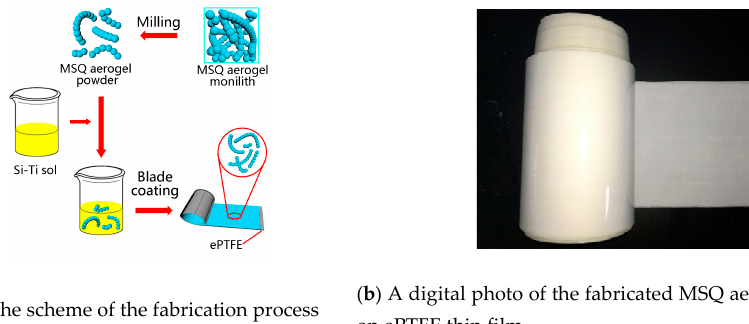
Figure 2. ( a ) The fabrication process for an MSQ aerogel coating layer on Polytetrafluoroethylene (ePTFE) thin film; ( b ) a digital photo of the fabricated large-scale MSQ aerogel coating on ePTFE thin film.